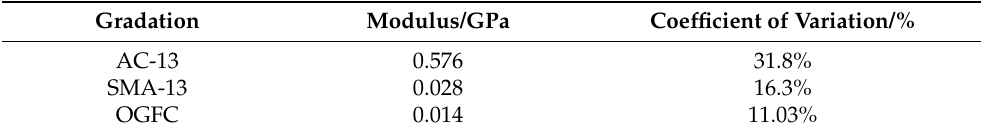
Table 3. Nanoindentation modulus of different gradation asphalt